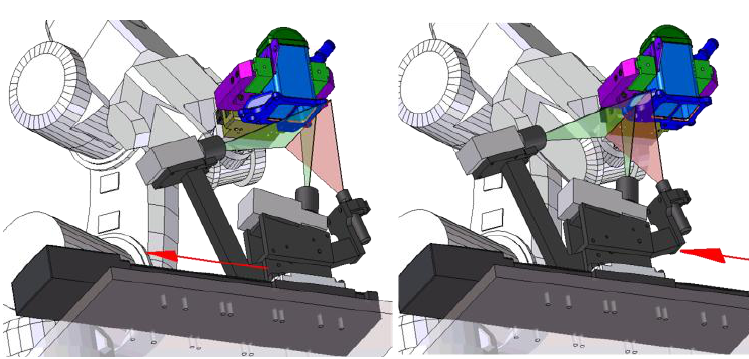
Figure 9. Scanning process.